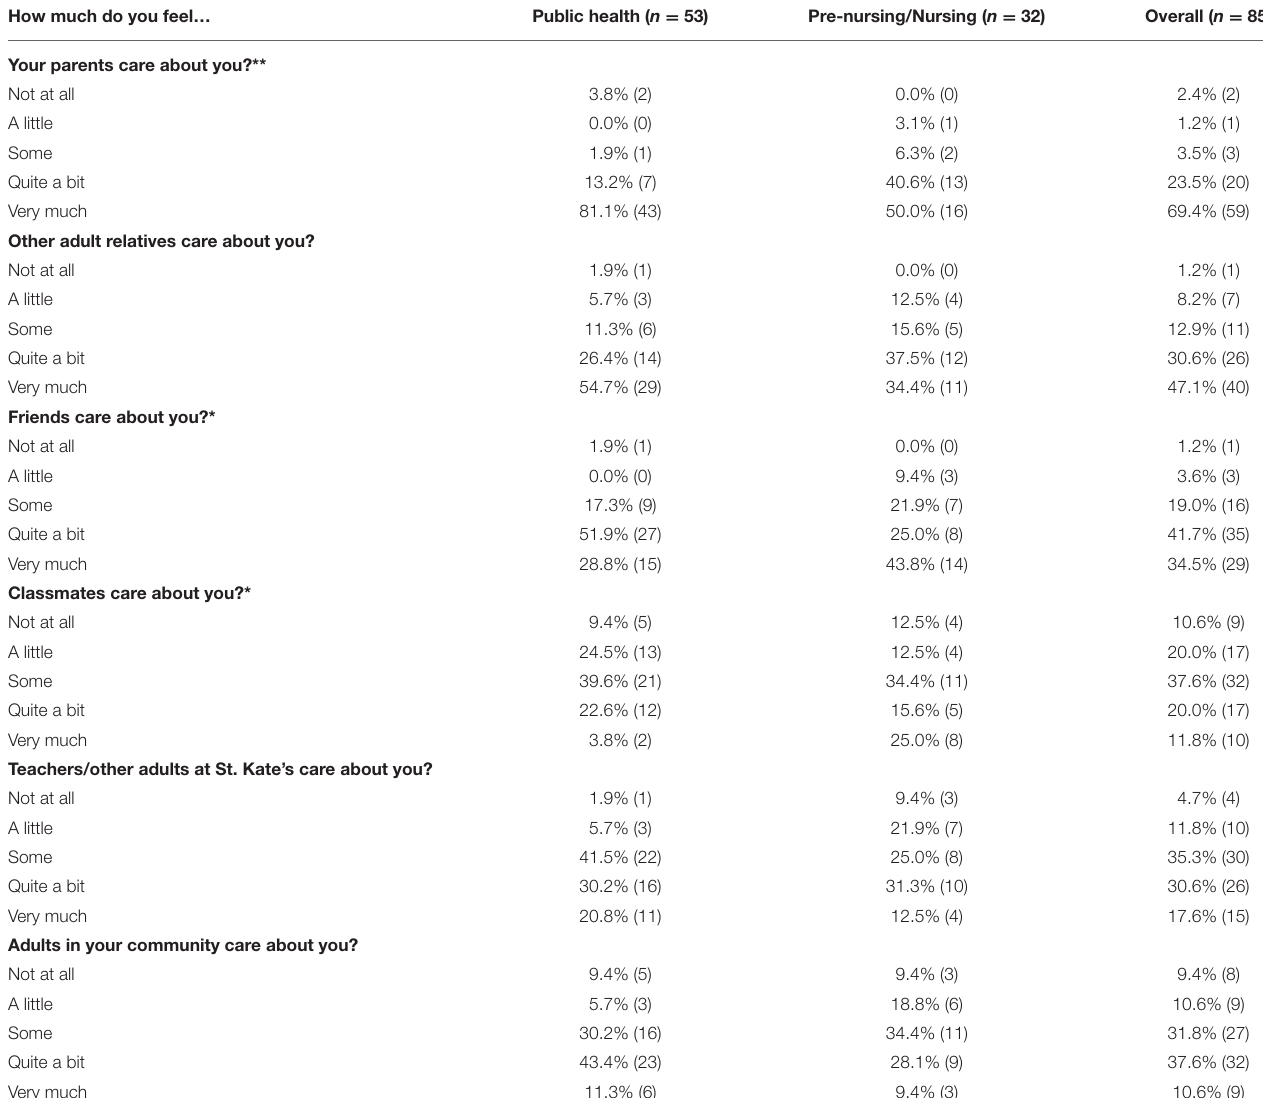
TABLE 3 | Social supports behaviors by